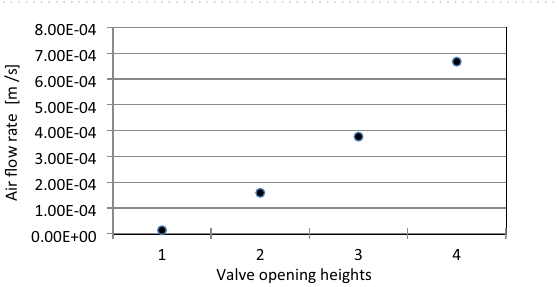
Figure 6. Relation between throttle opening values and different valve opening heights. Where: 3 m, 2 h 3.95 10 1 1 − − = ×